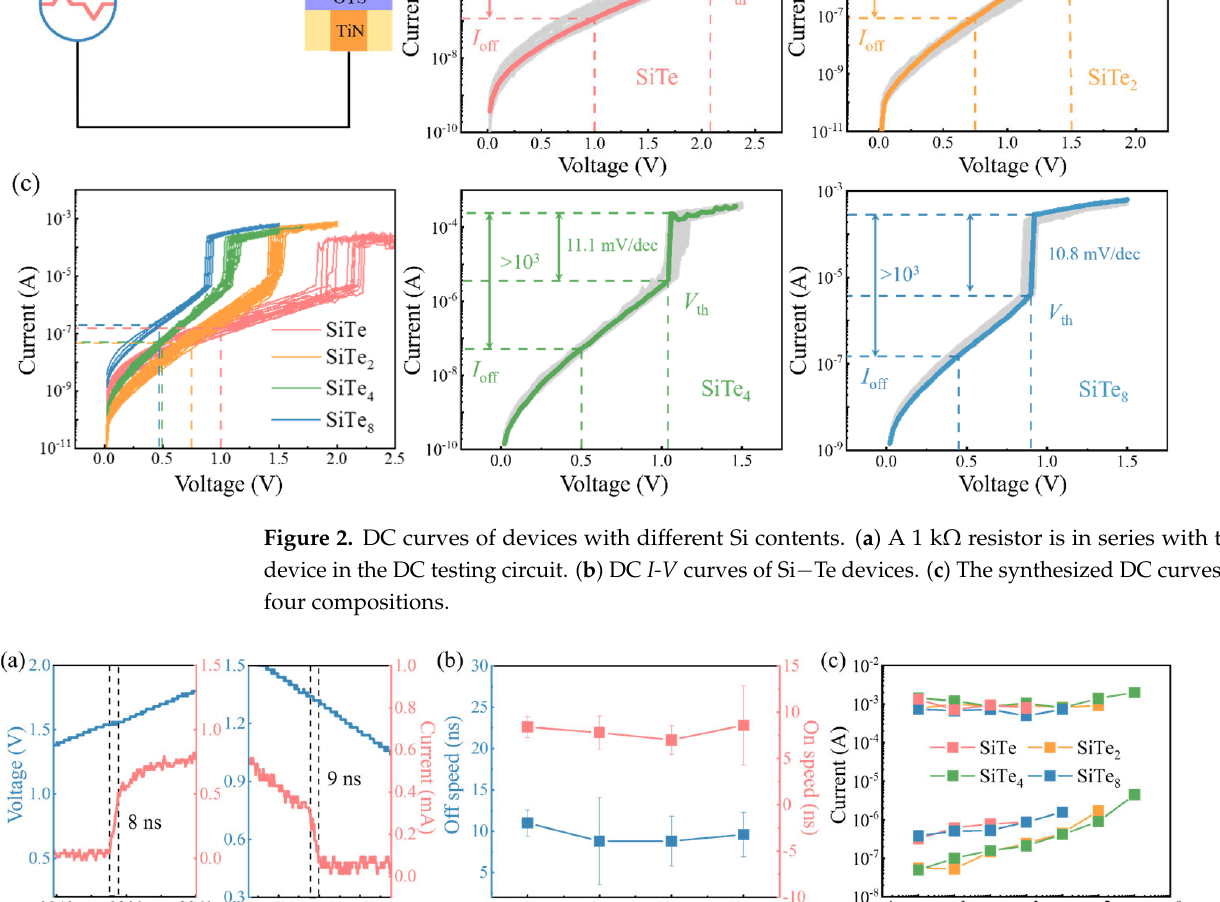
Figure 3. Speed and endurance distribution of Si–Te devices. ( a ) The on–speed and off − speed are 8 ns and 9 ns, respectively. ( b ) Statistical operating speeds distribution of different Si–Te devices. ( c ) Device lifetime of devices with all four compositions.